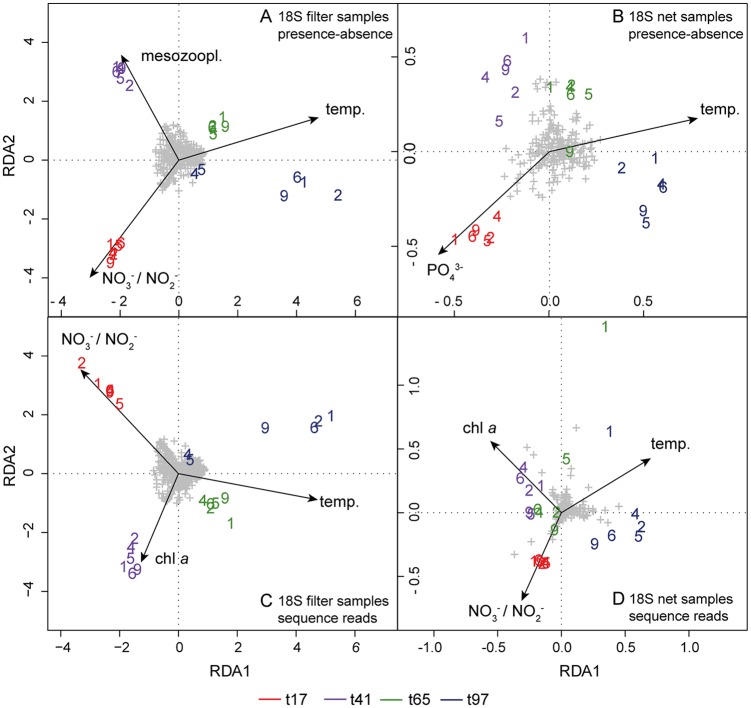
RDA of OTU compositions in dependence of ecological variables.Analysis of (A) filter samples, based on the 18S presence-absence-transformed data, (B) net samples, based on the 18S presence-absence-transformed data, (C) filter samples, based on the 18S sequence read data and (D) net samples, based on the 18S sequence read data. Mesocosms are indicated by their number. High CO2 (2, 4, 6) and ambient CO2 (1, 5, 9). OTUs are represented by grey plus signs. Time points are indicated by color: t17 = red, t41 = purple, t65 = green and t97 = blue. Explanatory variables are displayed as vectors, with NO3- / NO2- = nitrate and nitrite [μmol L-1], PO43- = phosphate [μmol L-1], temp. = temperature [°C], chl a = chlorophyll a [ng L-1], mesozoopl. = mesozooplankton [ind L-1]. Only significant ecological variables were retained for the respective RDA plot. Thus, variables shown vary for the four RDA plots.